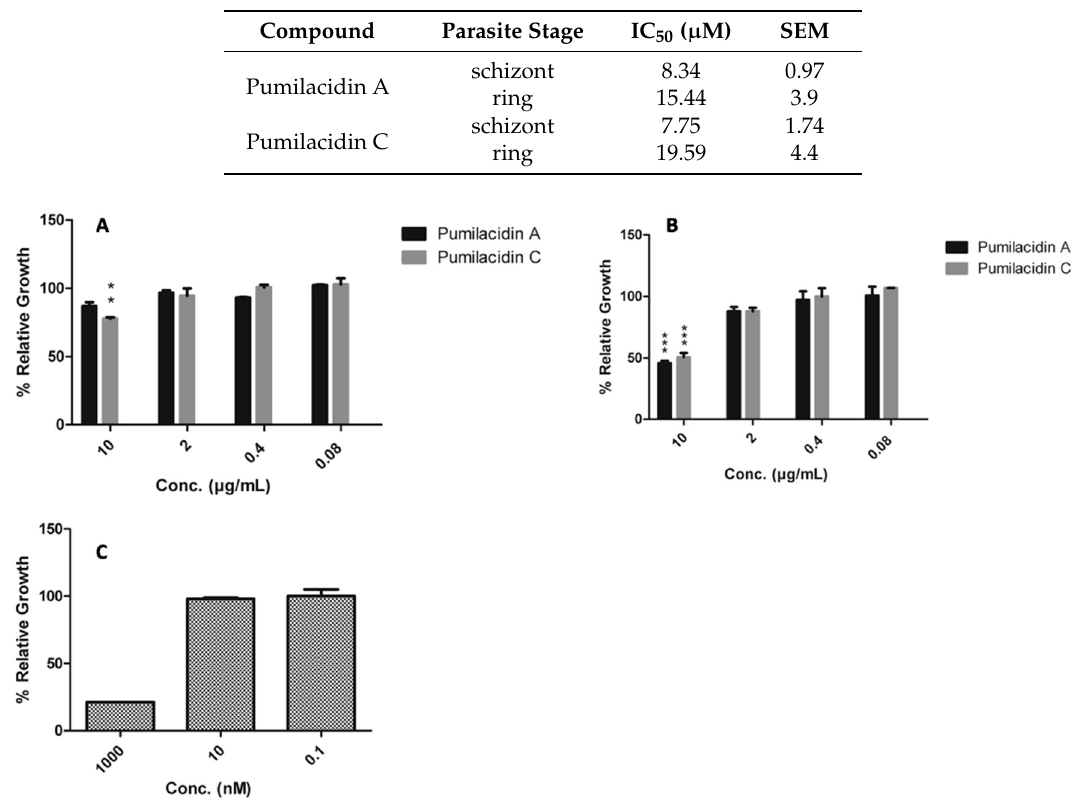
Table 1. Antiplasmodial activity of pumilacidins on different parasite stages. The data shown are from three experiments run in duplicate. IC 50 —half maximal inhibitory concentration; SEM—standard error of the mean.